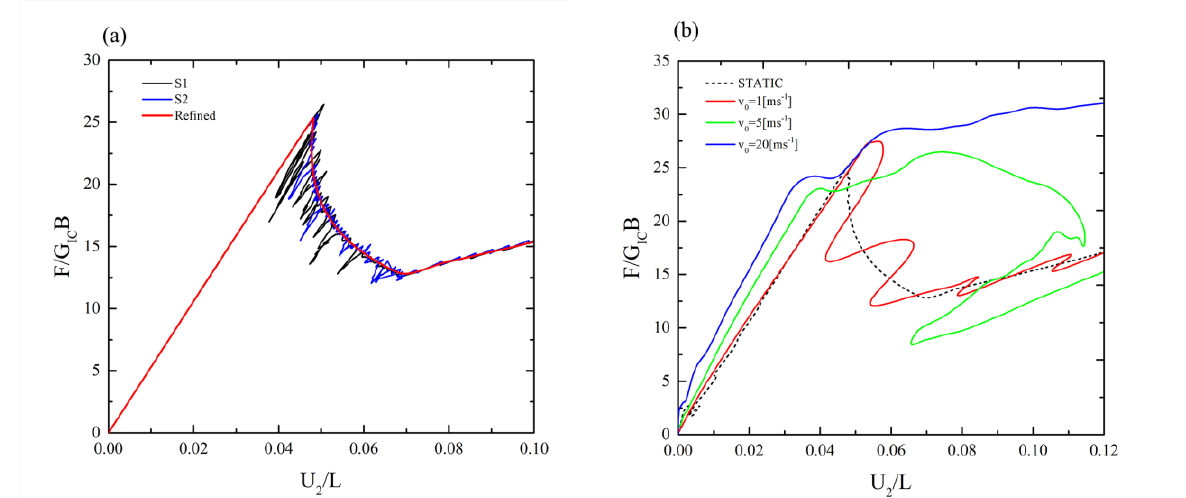
Fig. 5 . Loading curve variability in terms of mesh discretization for MMB test (a); Variability of the load- displacement curves in terms of loading rate for MMB test (b).